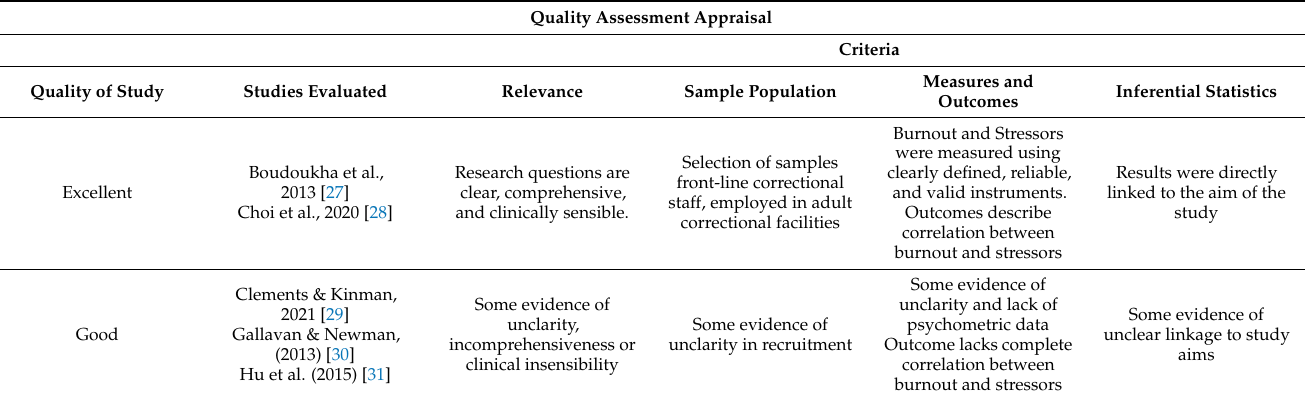
Figure 1. Burnout Systematic Review Flowchart. Table 2. Stage 1 Quality Assessment Appraisal for